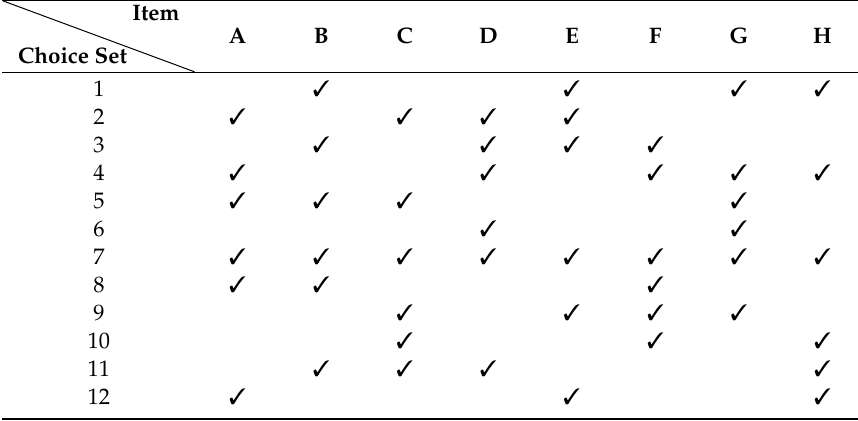
Table 2. Orthogonal main e ff ect design for best-worst scaling